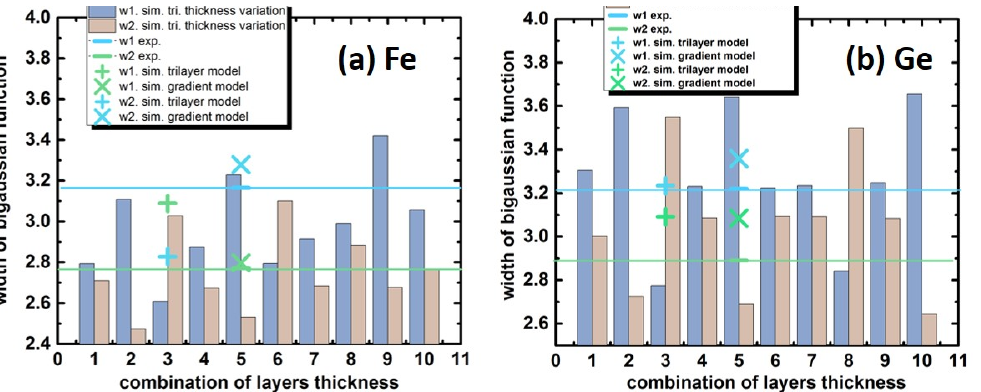
Figure 6. Analysis of asymmetry of the peaks of the RBS spectra for Fe 3+ x Si 1 − x /Ge/Fe 3+ x Si 1 − x /Si(111) (sample #7) with bigaussian function; blue and green lines refer to the experimental values of peak asymmetry observed for ( a ) Fe and ( b ) Ge; green marks corresponded to trilayer or gradient model fits as discussed; and bars indicate the asymmetry values for the different combinations of thickness in the trilayer model.